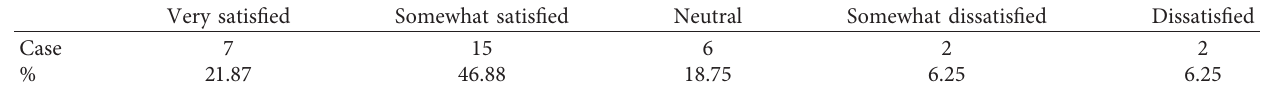
Table 5: The patient’s satisfaction after PRF ( n �